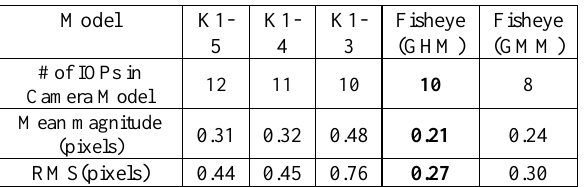
Table 4.Calibration Precision of GoPro Hero5 camera system using various calibration models in terms of image residuals, based on 3D target field